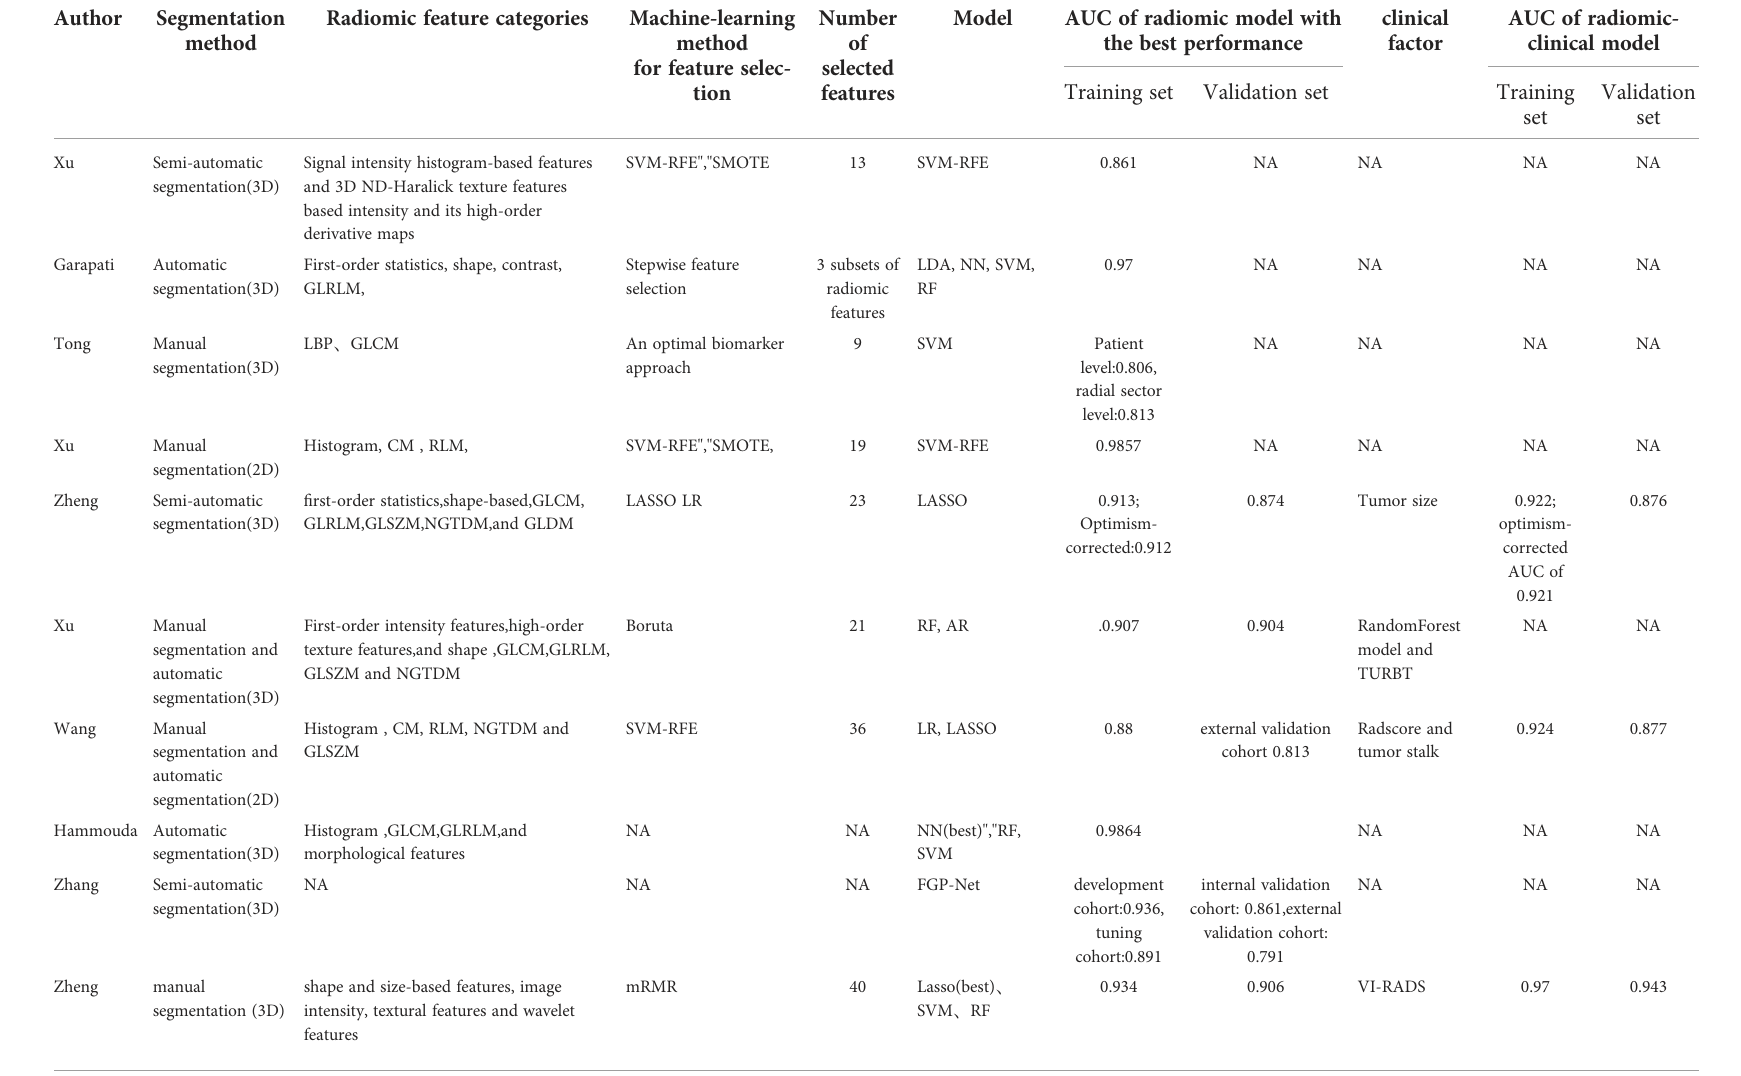
TABLE 2 Radiomic characteristics of studies included in the systematic